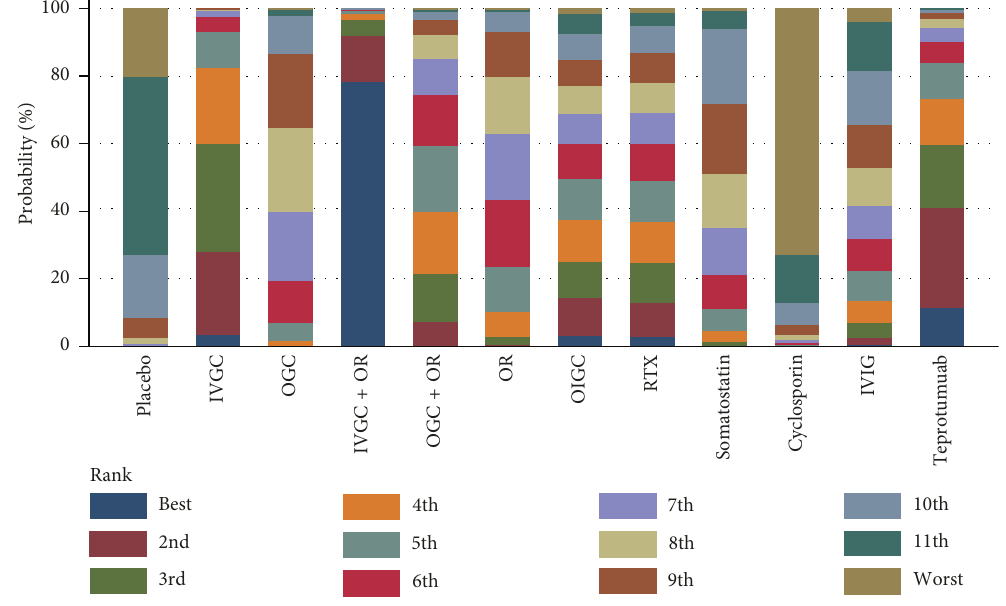
Figure 5: Rank probability of each treatment strategies for response rate in the network